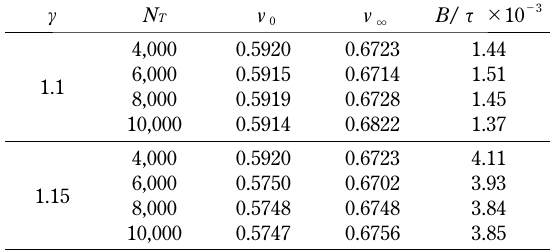
Table 3. Fitting parameters for inverse logarithmic law